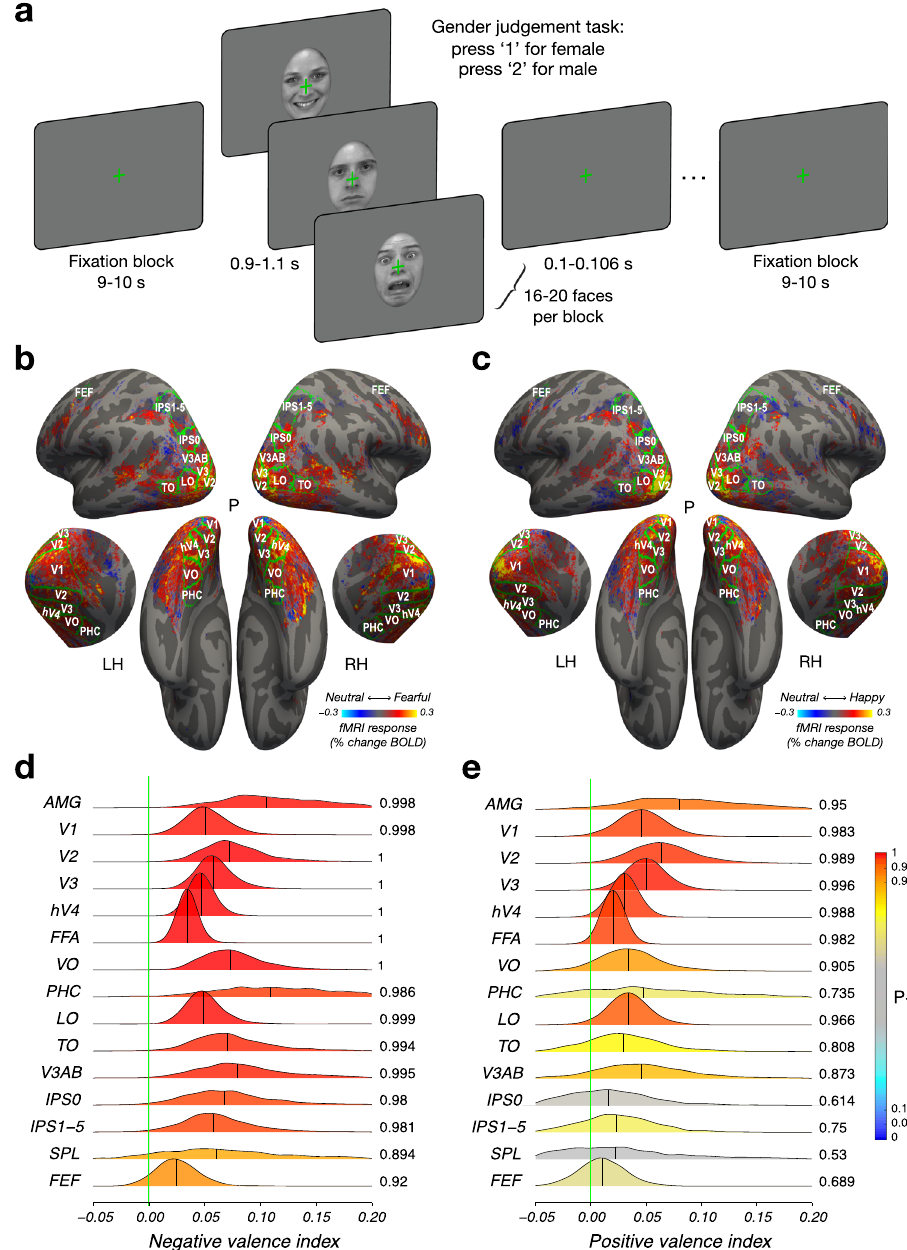
Fig. 1 | Distributionofvalencemodulationthroughout thebrain. a Stimuli and experimental protocol. Participants viewed a series of closely cropped face stimuli (KDEF image id: AF01HAS, AM22NES, and AM19AFS) balanced for low- level visual properties and blocked by emotional expression (happy, neutral, fearful) while performing a gender judgment task orthogonal to emotional expression. b Fearful facial expressions evoked a larger response than neutral facial expressions in nearly every area that exhibited visual responses. Hue indicates subtraction of response amplitude to neutral from fearful facial expressions foreachvoxelthatexhibitedareliablevisualresponse(coef fi cient ofdeterminationR 2 > 0.1)inatleastonethirdoftheparticipants. c Happyfacial expressions evoked a numerically larger response than neutral facial expres- sions in many areas that exhibited visual responses. Hue indicates subtraction of response amplitude to happy facial expressions and neutral facial expres- sions for each voxel that exhibited a reliable visual response (coef fi cient of